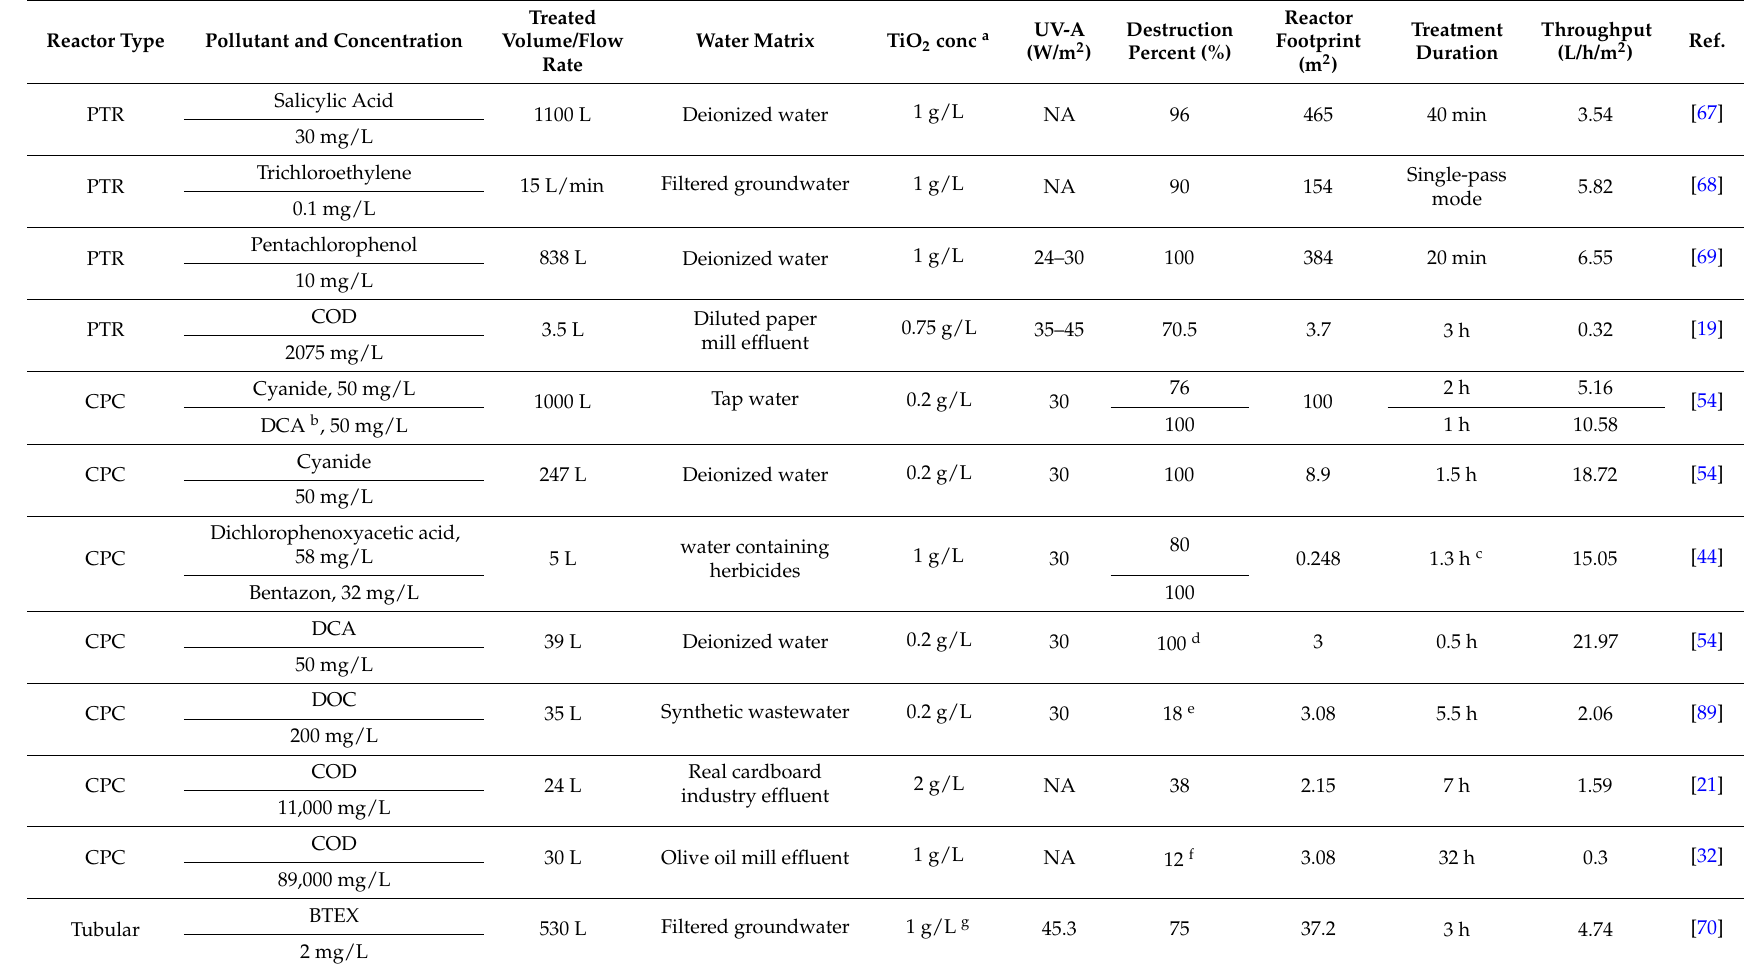
Table 2. Slurry Reactors throughput and degradation